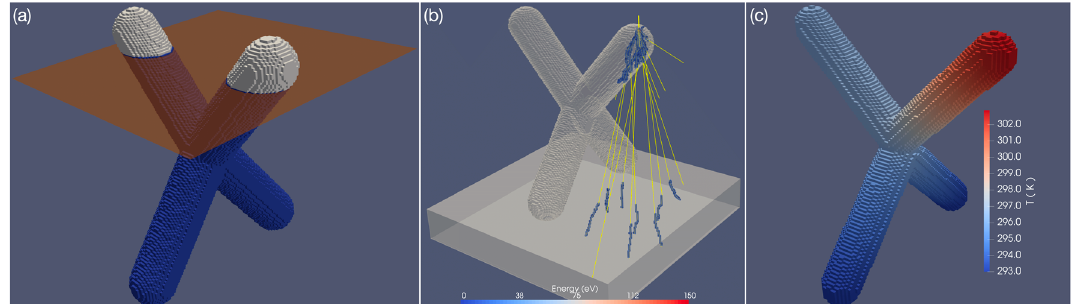
Figure 2. ( a ) Exemplary 3D computer-aided design (CAD) model of a ferromagnetic tetrapod structure with slicer plane for 2D pattern generation, for illustration. ( b ) Result of Monte Carlo simulation of several primary electron trajectories at 20 keV energy for tetrapod structure illustrating elastic scattering (yellow trajectories) and deposited energy (colour bar), due to inelastic scattering. ( c ) Temperature distribution in tetrapod structure under electron beam exposure at 20 keV and 44 pA beam current, when the electron beam hits at the topmost upper front arm (stationary state finite difference solution of heat conduction equation). The temperature increase is from 293 K at the base of the structure to about 303 K at the beam impact position; material parameters of Pt 20 C 80 .